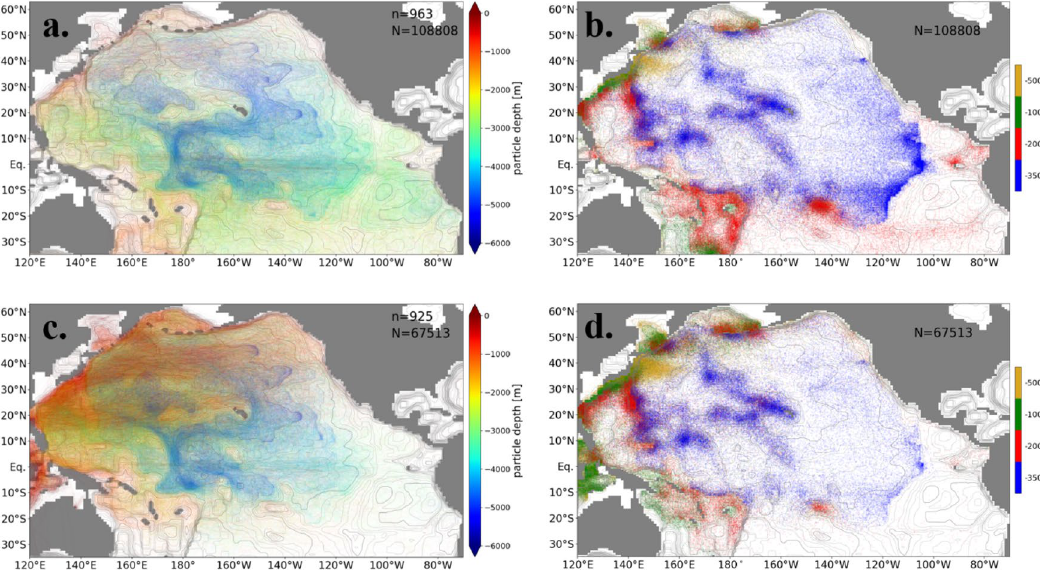
Figure 4. Same as Fig. 3, but the particles with around the median residence time (45–55%) in the Pacific Ocean. The particles reaching the Arctic Ocean and atmosphere (evaporation) are not the particles are transported by the Kuroshio, its extension, and the North Pacific subarctic gyre, and reach the Bering Strait (Fig. 3e). The particles on the secondary pathway ascend around the Kuril and Aleutian Islands, where the turbulent vertical mixing is locally enhanced, from the bottom layer to the shallow layer (Fig. 3f). The trajectories and ascending points of particles evaporating within the Pacific Ocean are similar to those reaching the Arctic Ocean below the intermediate layer (> 1000 m depth). Evaporation of particles mainly takes place in the equatorial Pacific Ocean (figure not shown). The particles are transported to the low-latitude region by the North Pacific subtropical gyre and the Equatorial Counter Current in the shallow layer (Fig. 3g and h). The particles which reside longer in the North Pacific Ocean follow different pathways. Here, the trajecto- ries are extracted for the particles with around the median residence time (between 45 and 55 percentiles) in the Pacific Ocean. (Fig. 4). The returning routes in the deep layer to the Southern Ocean are localized in the western part of the Southwest Pacific Basin for the short-staying particles (Fig. 3a and b), while the routes of the medium-term-staying particles are distributed over the whole Pacific Ocean (Fig. 4a and b). In summary, the main pathway of particles transported to the Southern Ocean in the deep layer is found in the western part of the Southwest Pacific Basin, and the secondary is found in the Southeast Pacific Basin. This main pathway differs from previous suggestions inferred from the distribution of temperature and salinity: along the eastern edge of the Southwest Pacific Basin 2 or eastern boundary of the Pacific Ocean 9 . The pathway of the short-staying particles that reach the Indian Ocean is localized in the western Pacific Ocean (Fig. 3c), while the pathway of medium-term staying particles spreads over the Pacific Ocean (Fig. 4c). The ascending points are also distributed in the whole Pacific Ocean in the bottom and deep layers (Fig. 4d). These features of the pathway are similar for the particles reaching the Arctic Ocean and the atmosphere (figure not shown). Even when the trajectories are randomly selected from all particles, the main pathways are little influenced compared with the case of medium-term staying particles (Figure S1). They are, however, obscured because the slower particles are more likely to be scattered over the whole deep Pacific Ocean. Dependency on flow field.